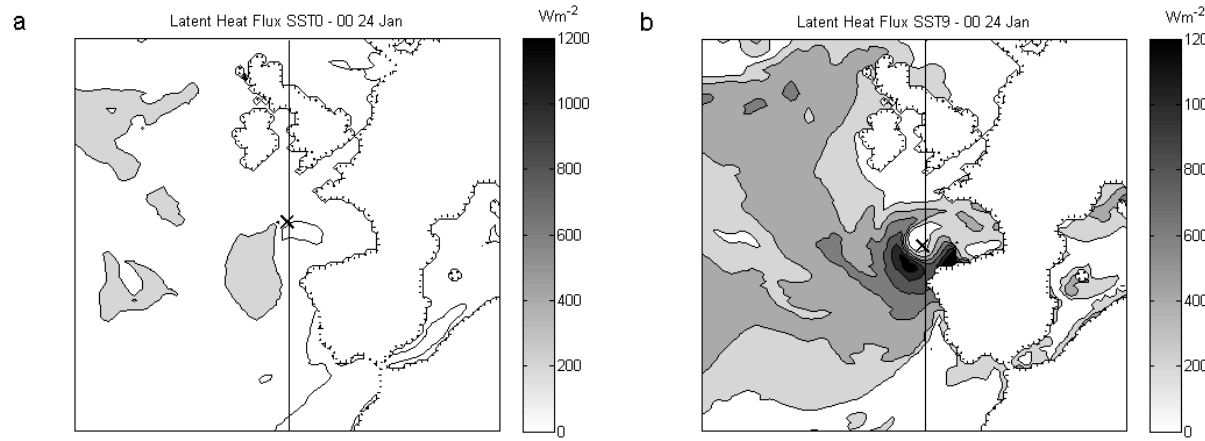
Figure 7. Surface latent heat flux [W m -2 ] at 12 UTC 23 for simulations SST0 (a) and SST9 (b). The sign X indicates the cyclone center, the vertical line is for the cross